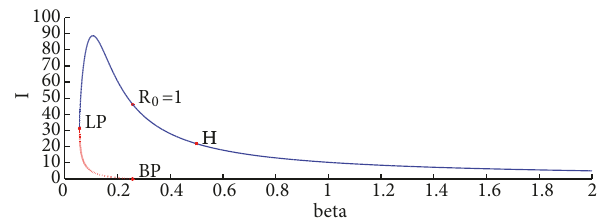
Figure 7: Bifurcation diagram showing the movement of endemic equilibriaas 𝛽 isvaried.Theverticalaxisindicatesthesizeofinfected population at equilibria.